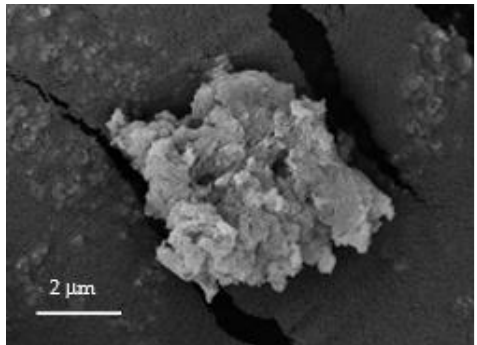
Figure 1. FESEM image of NH 2 KIT-6.